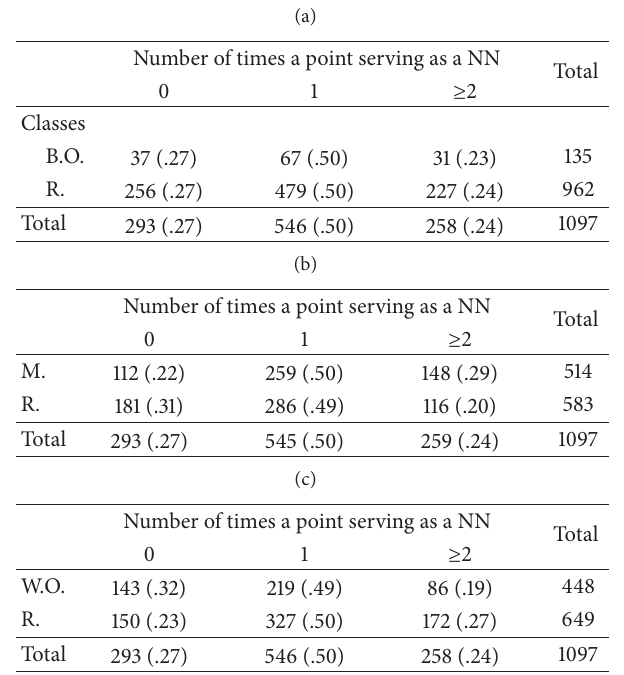
Table 21: The (reduced) 𝑄 -symmetry contingency tables for the one-versus-rest analysis for the Lansing Woods data. The relative frequencies in parentheses are with respect to row sums. B.O. stands